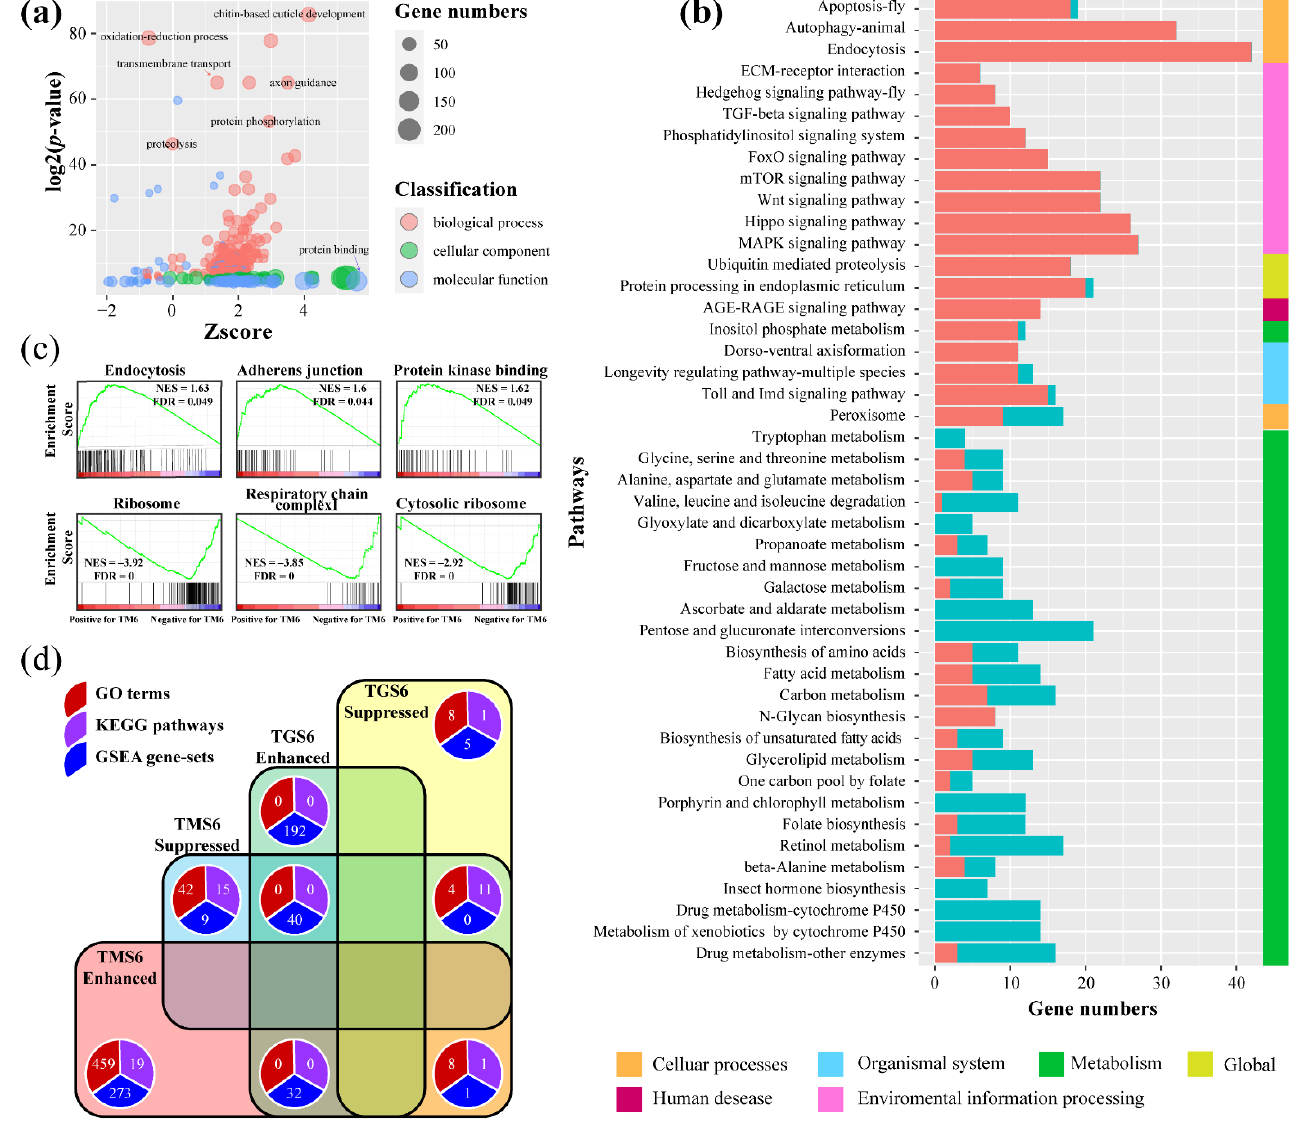
Figure 4. Pathway analysis for TMS6 group. ( a ) GO enrichment analysis for the TMS6 group. The X-axis represents the z-score of the GO terms; the calculation method is presented in the Materials and Methods section. ( b ) KEGG pathway enrichment analysis for TMS6 group. The bar in salmon and turquoise represent the number of upregulated and downregulated genes assigned to the corresponding pathway, respectively. ( c ) GSEA analyses of gene sets for TMS6. NES, normalized enrichment score. FDR, false discovery rate. The top portion of the plot shows the running ES for the gene set as the analysis moves down the ranked list. The bottom portion of the plot shows where the members of the gene set appear in the ranked list of genes. Positive (red) and negative (blue) NES indicate higher and lower expression in TMS samples, respectively. ( d ) Venn diagram illustrating the specific or shared processes (GO terms, KEGG pathways, and GSEA gene sets) of enhanced or suppressed in TGS6 and TMS6. Enhance, GO terms/KEGG pathways enriched by upregulated genes, or GSEA gene sets enriched by genes relatively highly expressed at TM6 or TG6; suppressed, GO terms/KEGG pathways enriched by downregulated genes, or GSEA gene set enriched by genes relatively highly expressed at TS6.